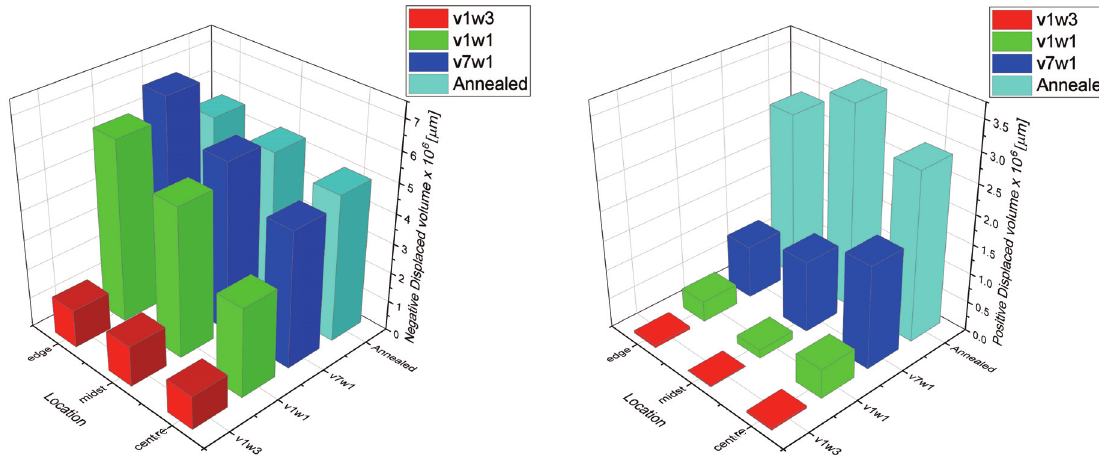
Fig. 7. The negative (left) and the positive (right) displaced volume generated by the dry sliding wear test on the annealed and processed